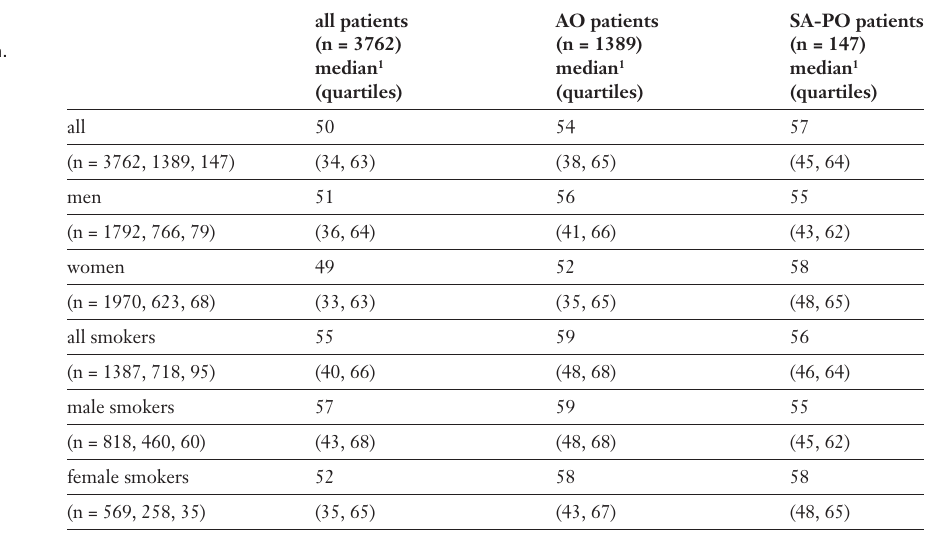
Demographic data.